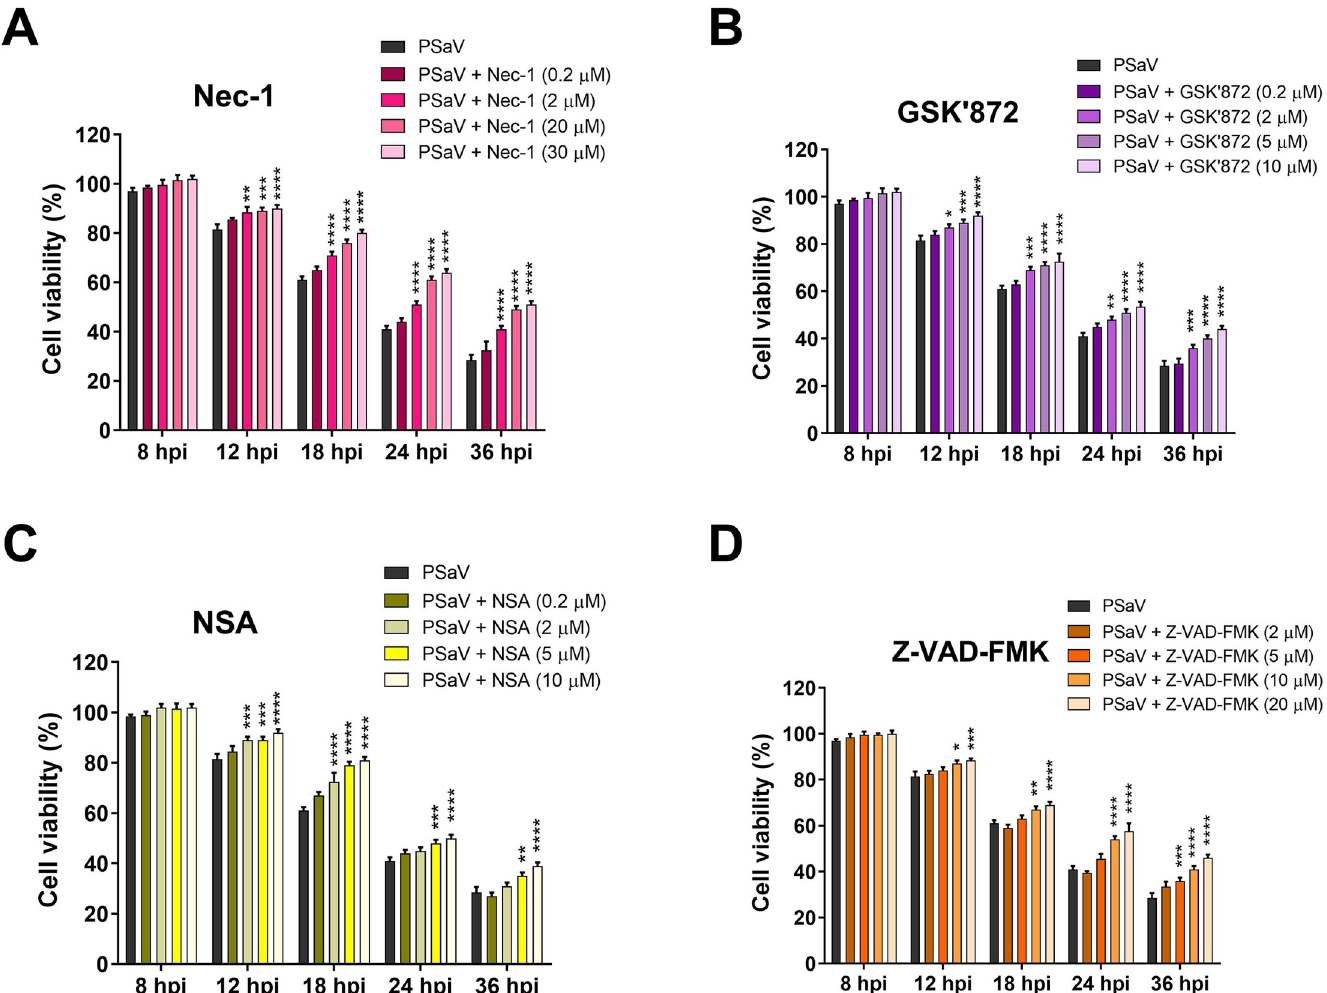
Fig 8. Inhibition of necroptosis or apoptosis reduces PSaV-induced cell death. (A-D) LLC-PK cells infected with PSaV Cowden strain (MOI = 1 TCID 50 ) were mock-treated or treated with different concentrations of Nec-1 (A), GSK’872 (B), NSA (C) or Z-VAD-FMK (D) and then incubated in the presence of 200 μ M GCDCA for the indicated time points. Cell viability determined by MTT assay was compared with that in the mock-treated and virus-infected cells. All experiments were performed in triplicate and the data represent the means ± standard errors of the mean. Differences were evaluated using two -w ay ANOVA. � p < 0.05; �� p < 0.01; ��� p < 0.001; ���� p <